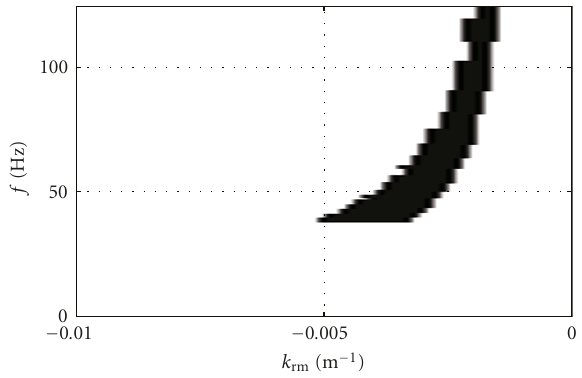
Figure 9: Binary mask used to filter mode no. 4.